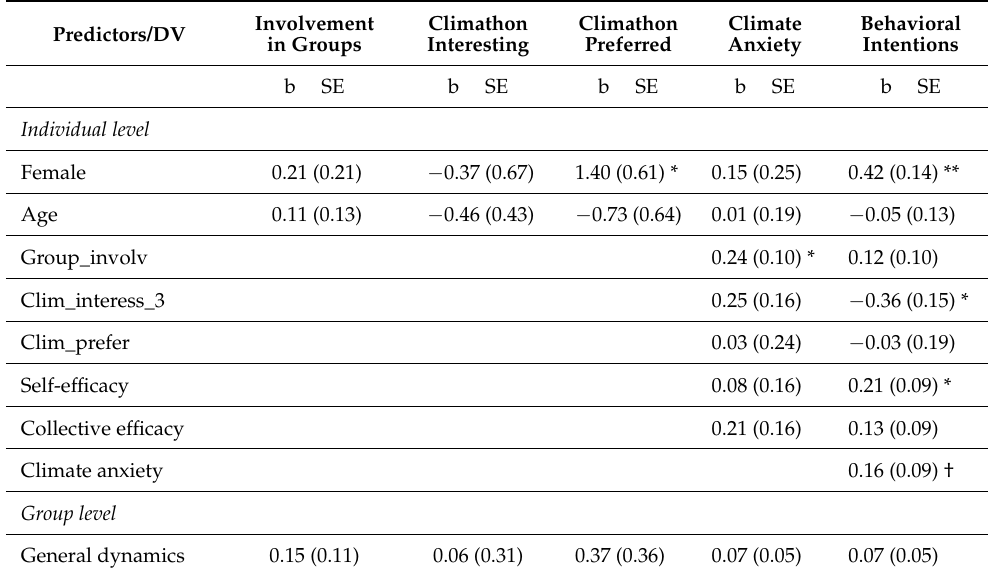
Table A2. Results of multilevel regressions, with the general score of group dynamics as group- level predictor.